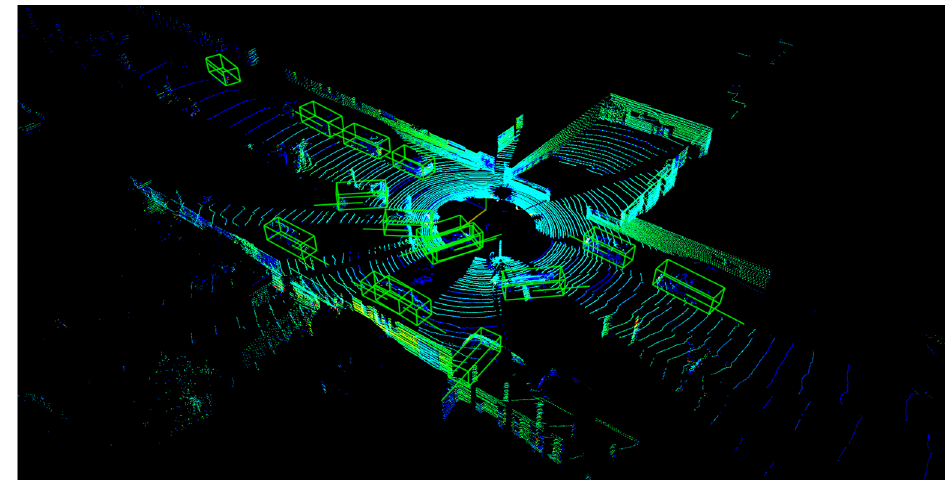
Figure 9. The omnidirectional detection results from PointRCNN.